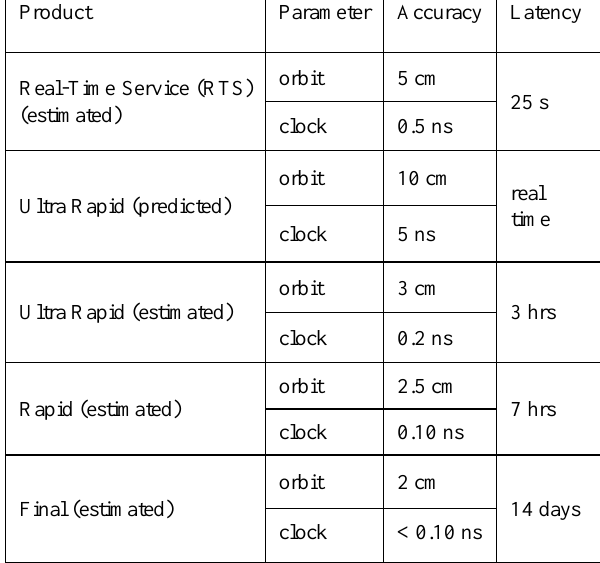
Table 2. Precise GPS satellite orbits and clock